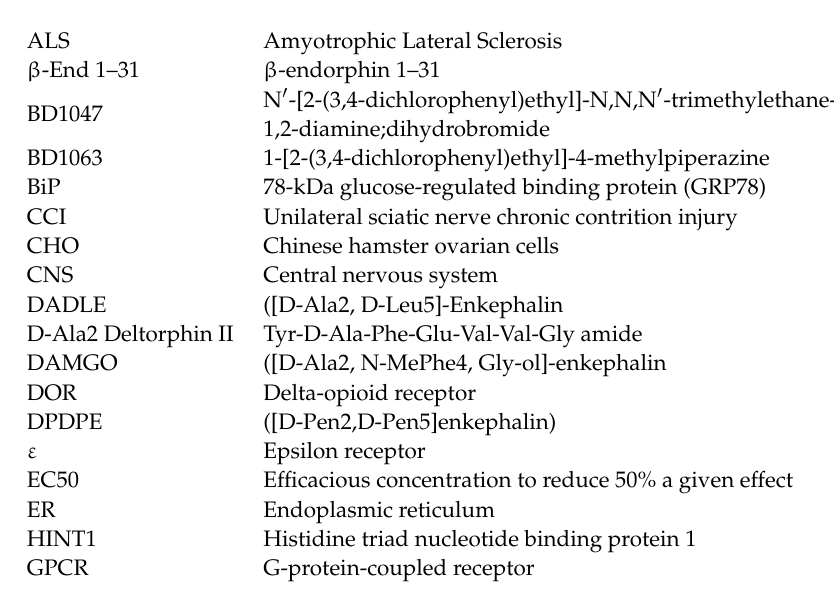
Figure S4: In vitro made σ 1R oligomers. Figure S5: Effect of σ 1R antagonist S1RA and α N-acetyl β -End 1–31 on the association of σ 1R E102Q mutant with NR1 C1 and σ 2R. Figure S6: Effect of σ 1R agonist PRE084 and β -End 1–31 on the association of σ 1R E102Q mutant with NR1 C1 and σ 2R. Figure S7: Effect of σ 1R agonist/antagonist ligands on σ 1R- σ 2R heterodimers. Figure S8: Effect of the physiological and nonphysiological sequences of β -End 1–31 and classical σ 1R ligands on BiP- σ 1R, σ 2R- σ 1R and NR1 C1- σ 1R associations. Figure S9: Effect of σ 1R agonist/antagonist ligands on σ 1R- NR1 C1 associations. Figure S10: Effect of σ 1R agonist/antagonist ligands on σ 1R-BiP associations. Figure S11: Purification of recombinants σ 1R and σ 2R proteins. Controls of σ 1R1/2 interaction with Tag proteins GST and